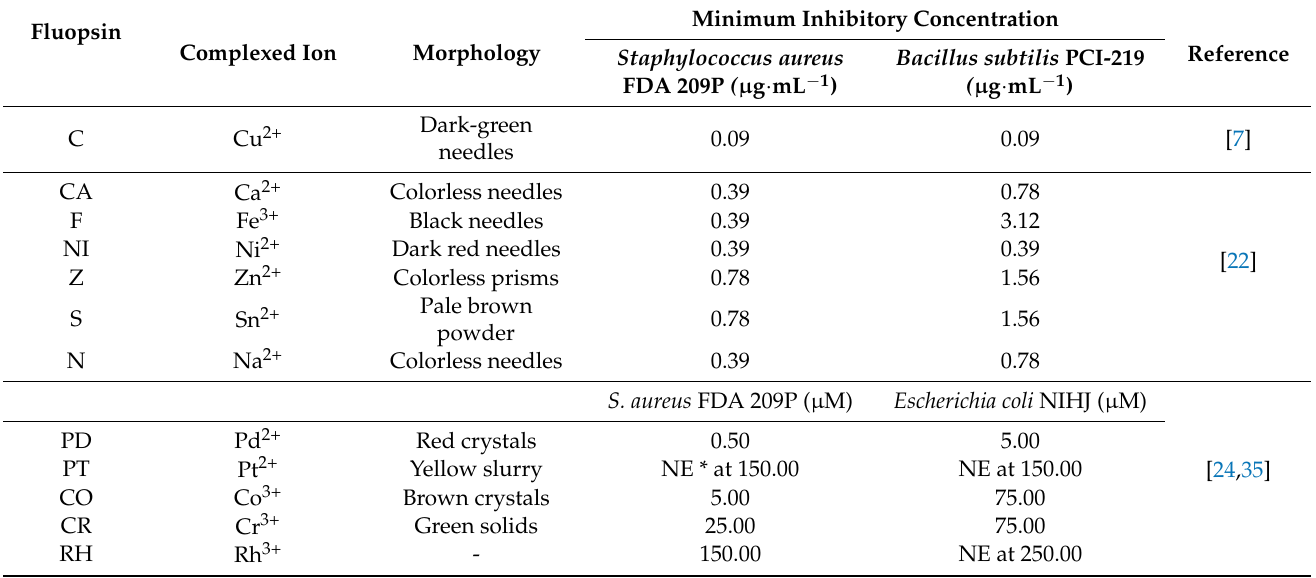
Table 2. Main organometallic complexes in the Fluopsin group (thioformin